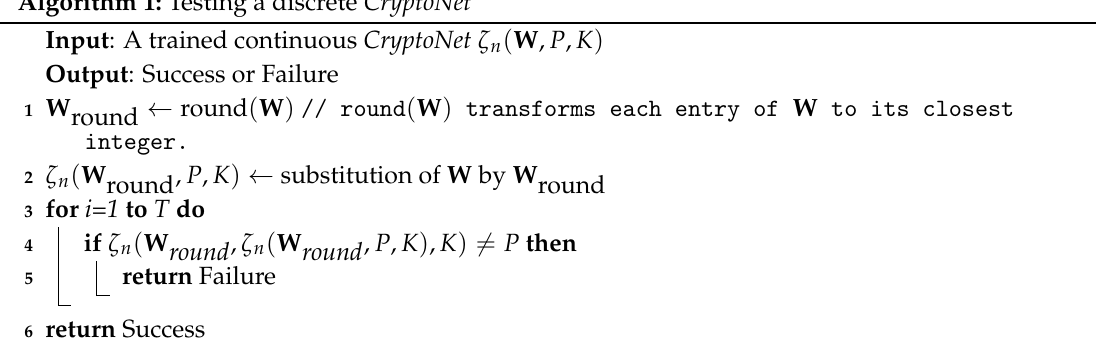
Algorithm 1: Testing a discrete